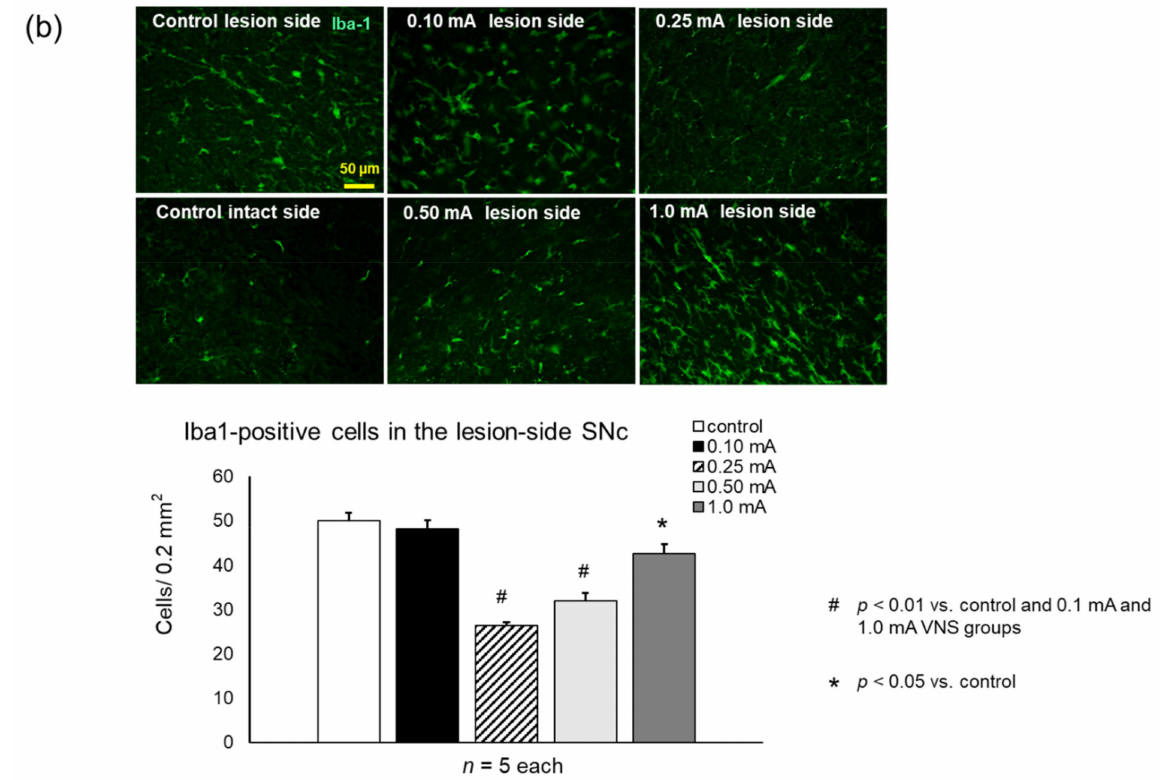
Figure 7. VNS with mild to moderate stimulation intensity inhibited proliferation of microglia both in the striatum and SNc. ( a ) Ionized calcium binding adaptor molecule 1 (Iba1)-positive microglia in the striatum of the lesion side. The number of Iba1-positive microglia in the lesioned SNc significantly decreased in the 0.25 mA and 0.5 mA VNS groups compared to the control group ( # p < 0.01). ( b ) Iba1-positive microglia in the SNc of the lesion side. The number of Iba1-positive microglia in the lesioned SNc significantly decreased in the 0.25 mA and 0.5 mA VNS groups compared to the control and 0.1 mA VNS groups ( # p < 0.01). Iba1-positive neurons in the SNc in the 1 mA VNS group also significantly decreased compared to the control group (* p < 0.05), although the effect was less than that of the 0.25 mA and 0.5 mA VNS groups. The data are presented as means ± SE and analyzed by one-way ANOVA and Turkey’s post hoc tests. n = 5